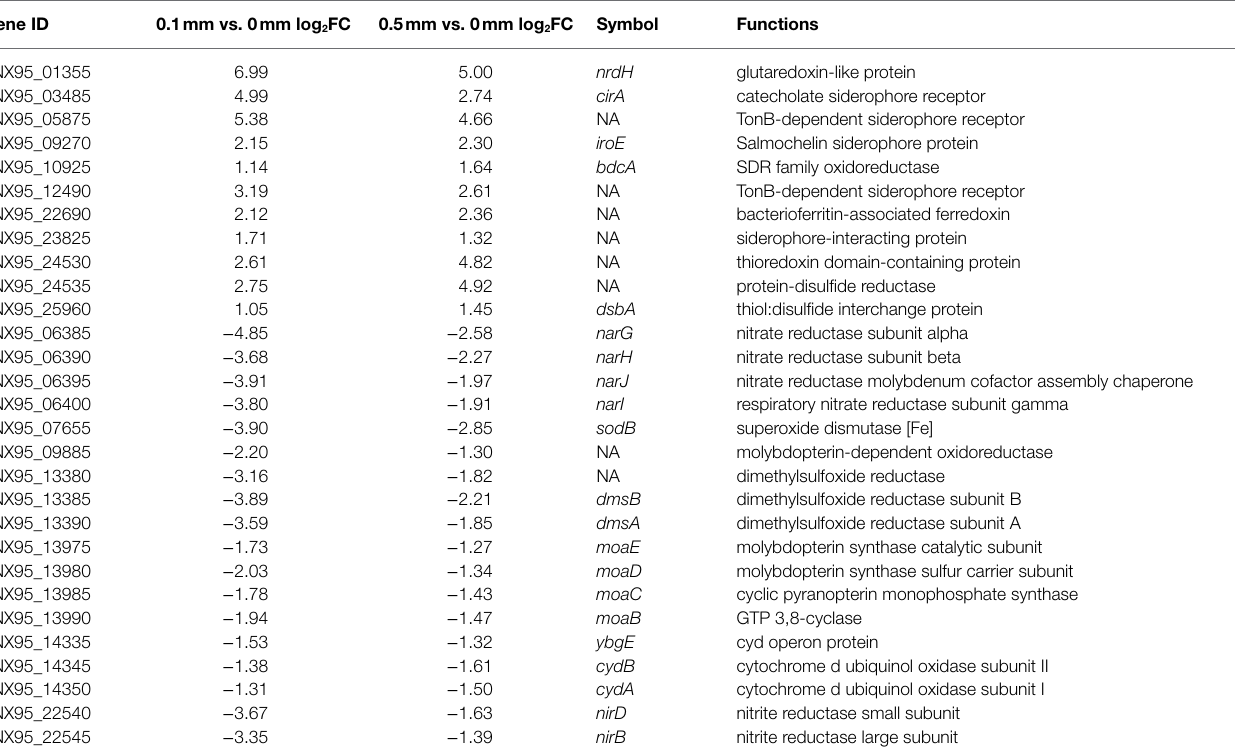
TABLE 1 | Differentially expressed genes (DEGs) with a dosage of 0.1 mm and 0.5 mm bromate in strain K. variicola Glu3. Gene